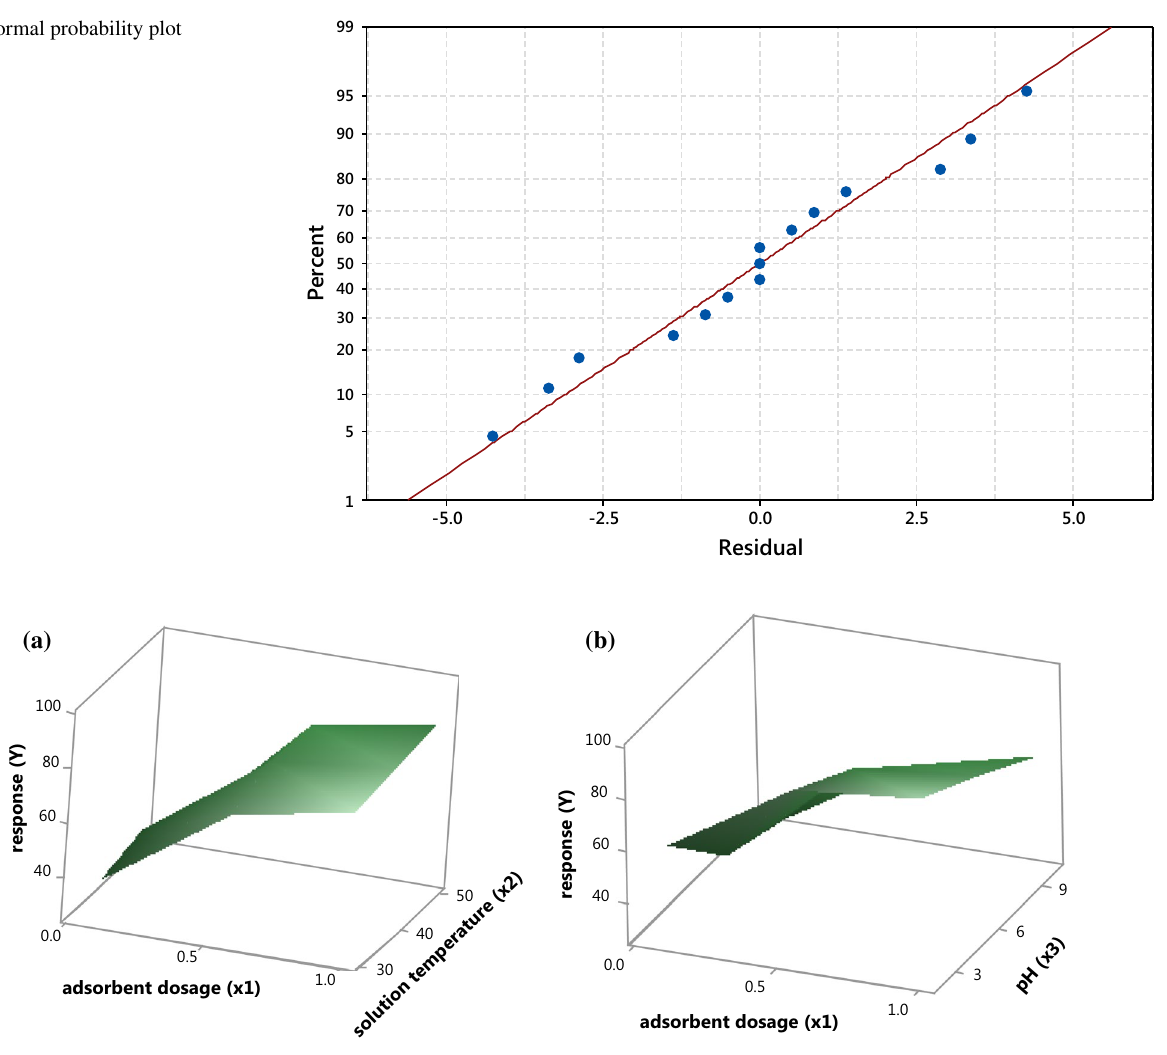
Fig. 1 Normal probability plot